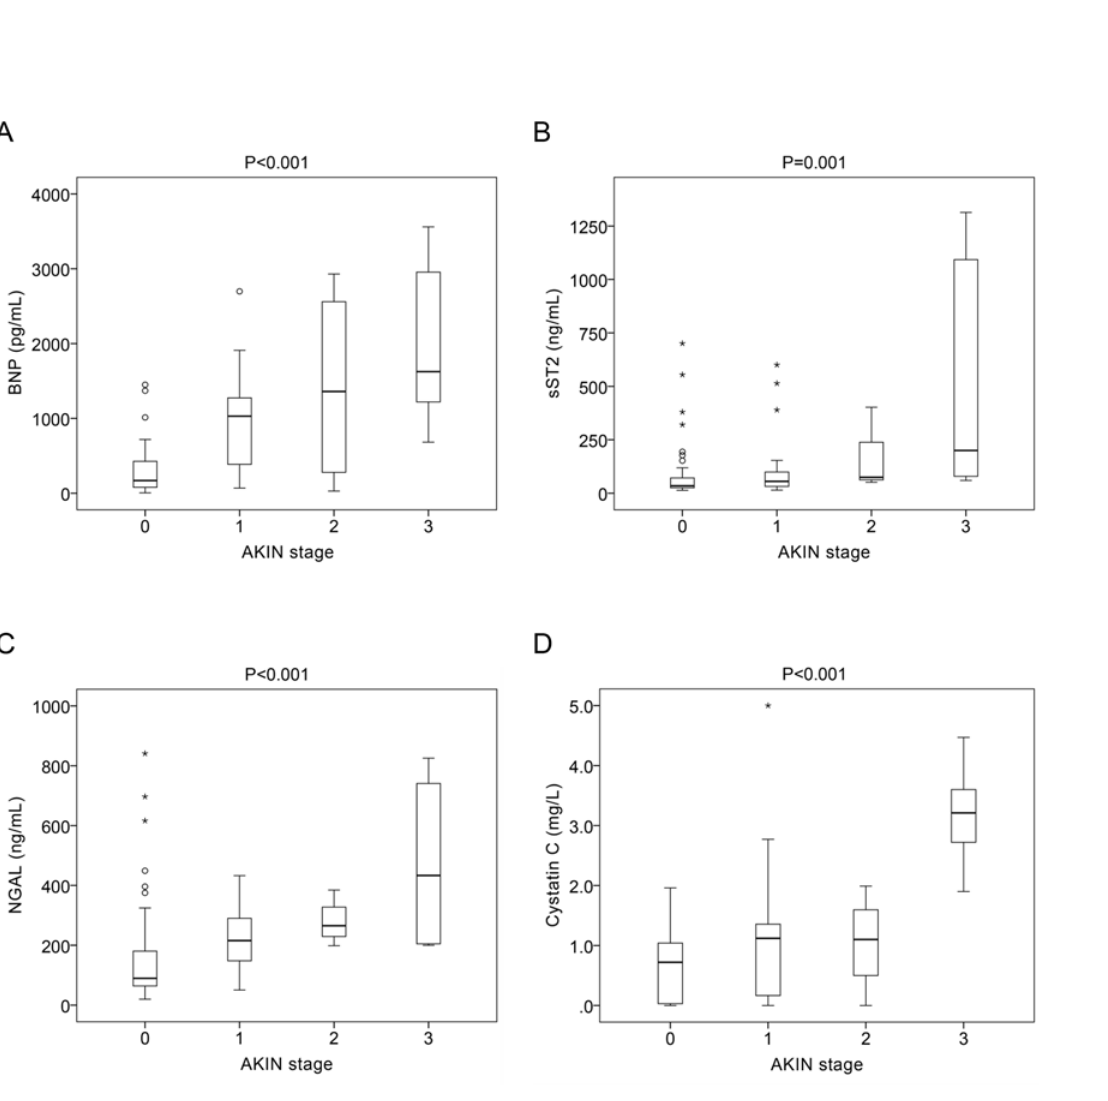
Fig 1. Serum levels of the biomarkers at presentation and the Acute Kidney Injury Network (AKIN) stages in patients developing acute kidney injury within 48 hours. Serum levels of BNP (A), sST2 (B), NGAL (C) and cystatin C (D) at presentation increased significantly across the spectrum of the AKIN stages within 48